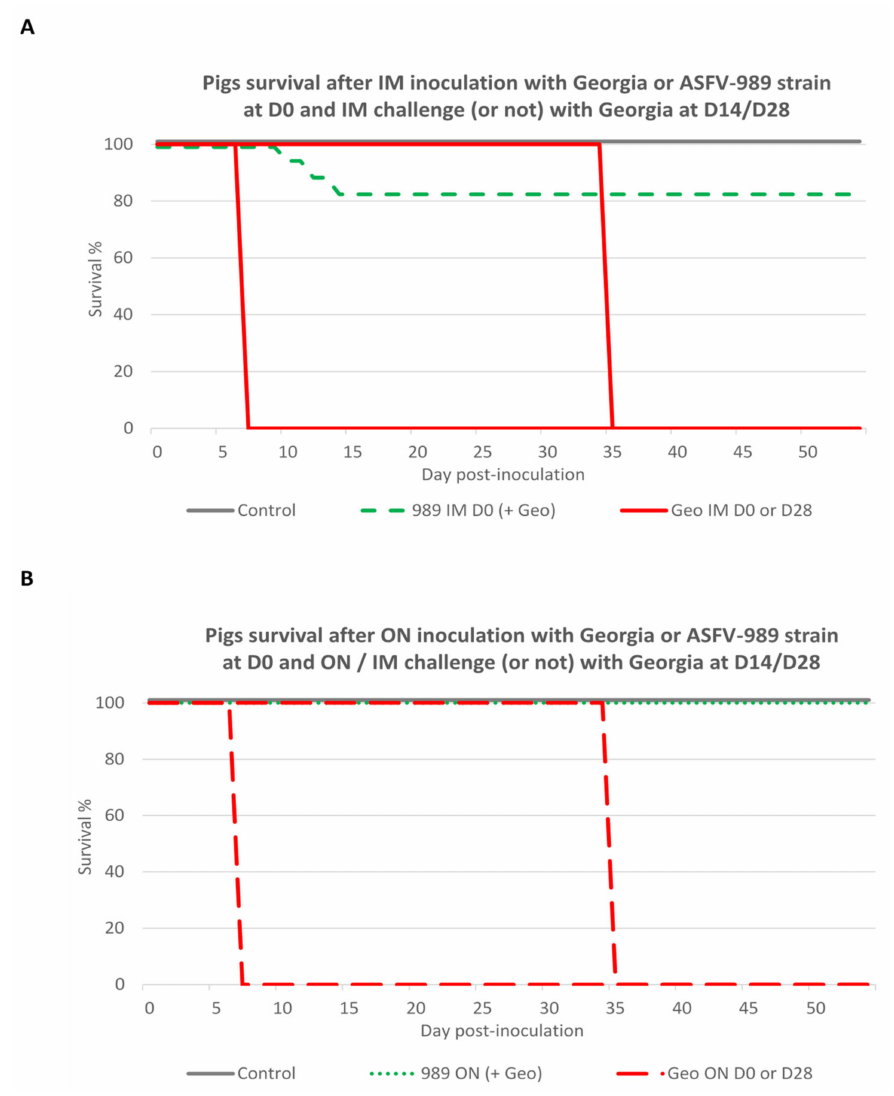
Figure 8. Survival curves for pigs inoculated with Georgia or ASFV-989 strains at D0 and then challenged or not with the Georgia strain. ( A ) Survival curves for pigs inoculated with ASFV-989 or Georgia by intramuscular route and challenged (or not) at D14 or D28 with Georgia strain via the same route (time in days post-inoculation). Control—data from group A1, A2, and A3; 989 IM D0—data from groups C, D, and K; Geo IM D0 or D28—data from groups E and G. ( B ) Survival curves for pigs inoculated with ASFV-989 or Georgia by oronasal route and challenged (or not) at D14 or D28 with Georgia strain via IM or ON route (time in days post-inoculation). Control—data from group A1, A2, and A3; 989 ON D0—data from groups B, H, I and L; Geo ON D0 or D28—data from groups F and